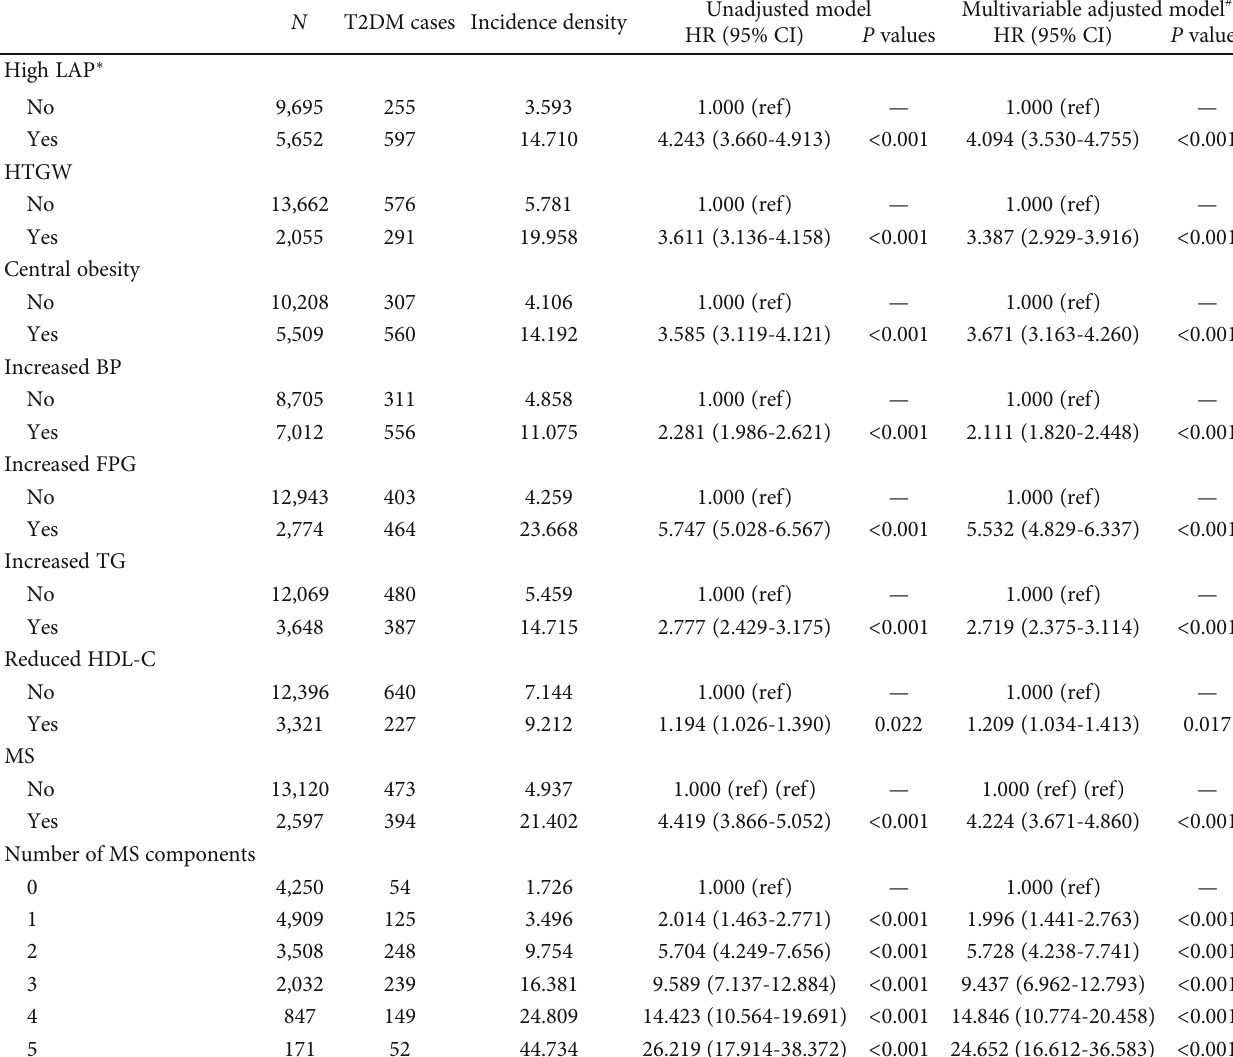
Table 3: Hazard ratios for the incidence of T2DM in di ff erent metabolic